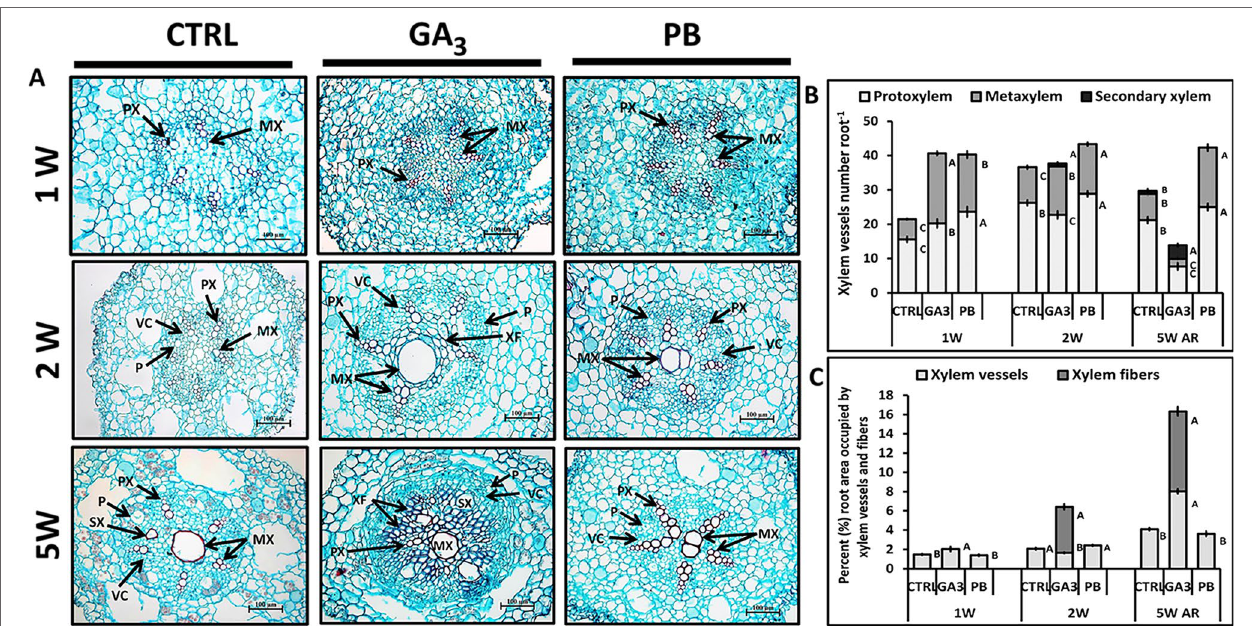
FiGURe 5 | Effect of GA 3 application on sweetpotato “ Georgia Jet ” root anatomy and xylem development. (a) Representative cross-sections of adventitious roots (AR) sampled at one, two, and five weeks (1W, 2W, and 5W, respectively) after planting. Sections were stained with safranin and fast green, and represent six to eight roots sampled from individual plants. Some of the vessels are lignified and stained red. (B) Xylem vessels number per AR, including protoxylem, metaxylem and secondary xylem sampled at 1W, 2W, and 5W. (c) Percent (%) root area occupied by xylem vessels (protoxylem, metaxylem and secondary xylem) and xylem fibers. Bars (B , c) represent mean of six to eight independent biological replicates (plants) ± SE. Significance analysis was performed by using student’s t-test ( P ≤ 0.05) , where unlike letters represent significant differences between treatments within a sampling group. CTRL, Control (treated with water); GA 3 , application of 50 ppm gibberellic acid 3 for two weeks; PB, application of 5 ppm paclobutrazol for two weeks. PX, protoxylem; MX, metaxylem; SX, secondary xylem; XF, xylem fibers; VC, vascular cambium; P, phloem. Scale bar = 100